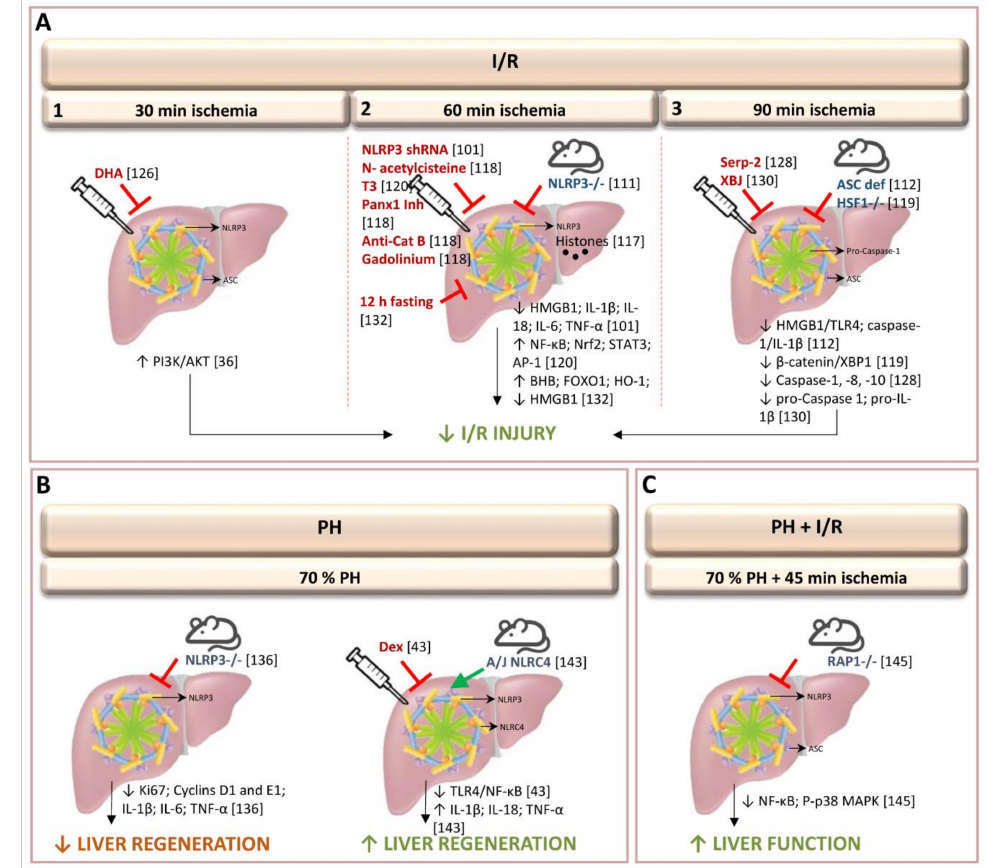
Figure 2. Schematic representation of the role of inflammasome in di ff erent experimental models of warm I / R injury. ( A ) Experimental models of 30 (A.1), 60 (A.2) and 90 (A.3) minutes of warm ischemia-reperfusion injury without hepatic resection. ( B ) Experimental models of partial